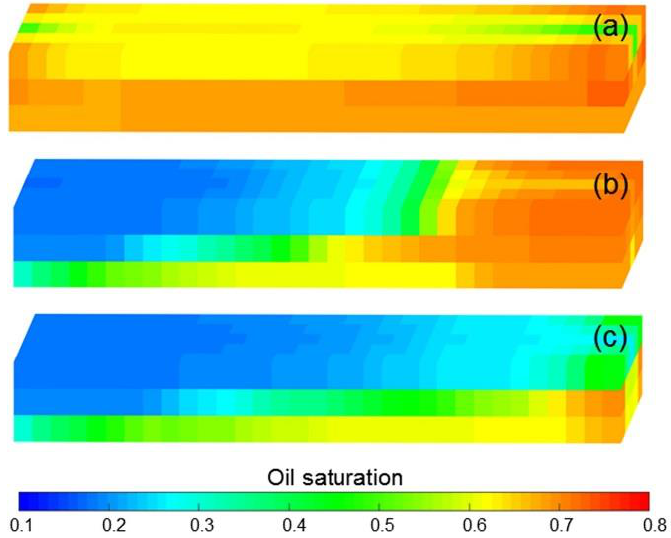
Figure 21. 3D remaining oil saturation distributions after ( a ) initial water flooding, ( b ) polymer flooding and ( c ) extended water flooding of Case 17.